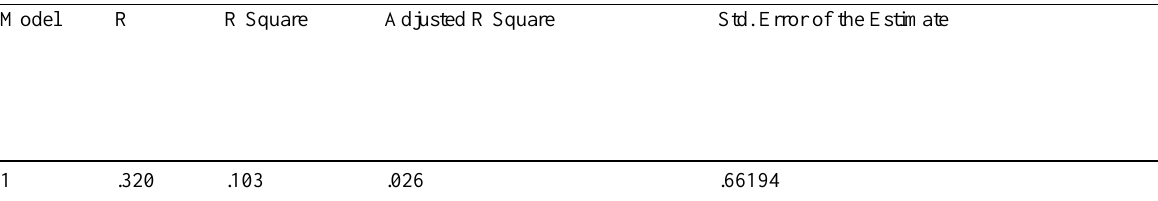
Table 5: Model Summary